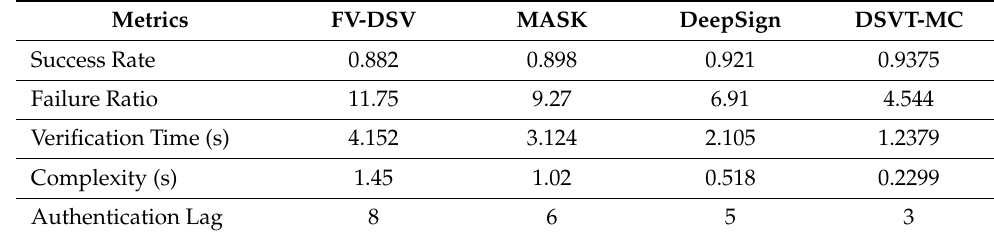
Table 2. Comparative analysis summary (sessions).